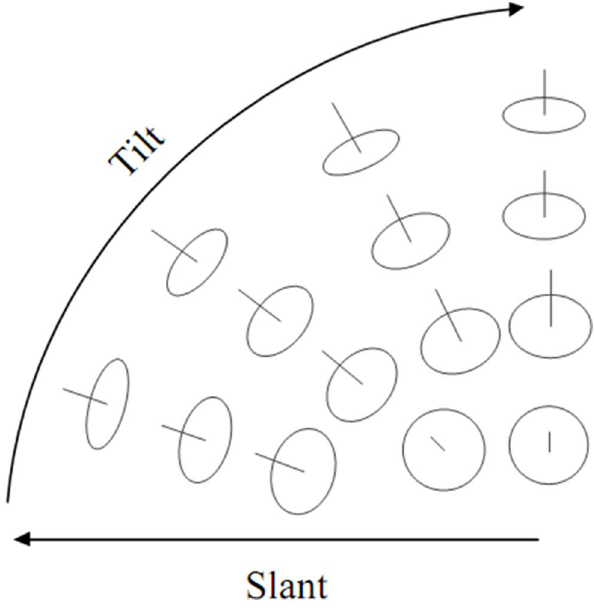
Figure 2. Texture scale variation using viewer centered spherical coordinate system. Tilt components of surface orientation is illustrated using a set of round patches arranged on a sphere. Central line at each patch shows the direction of the surface normal.